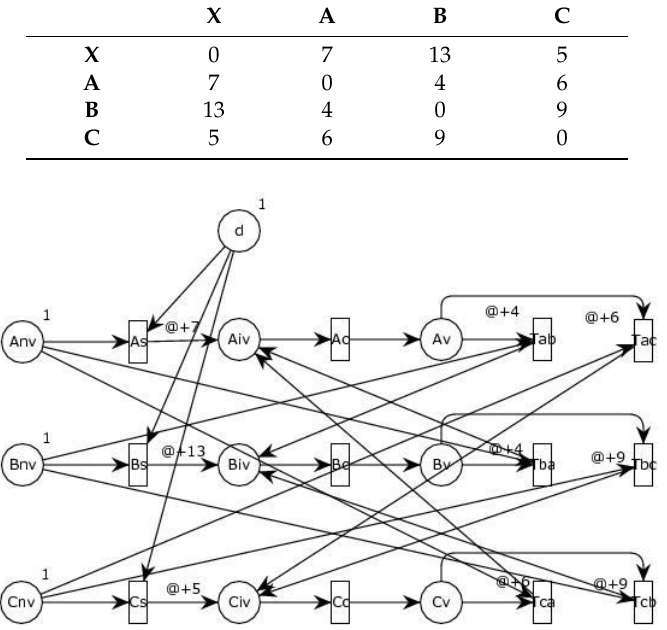
Figure 16. TSP involving three cities with symmetric cost Figure 15. TSP involving three cities with symmetric cost matrix.